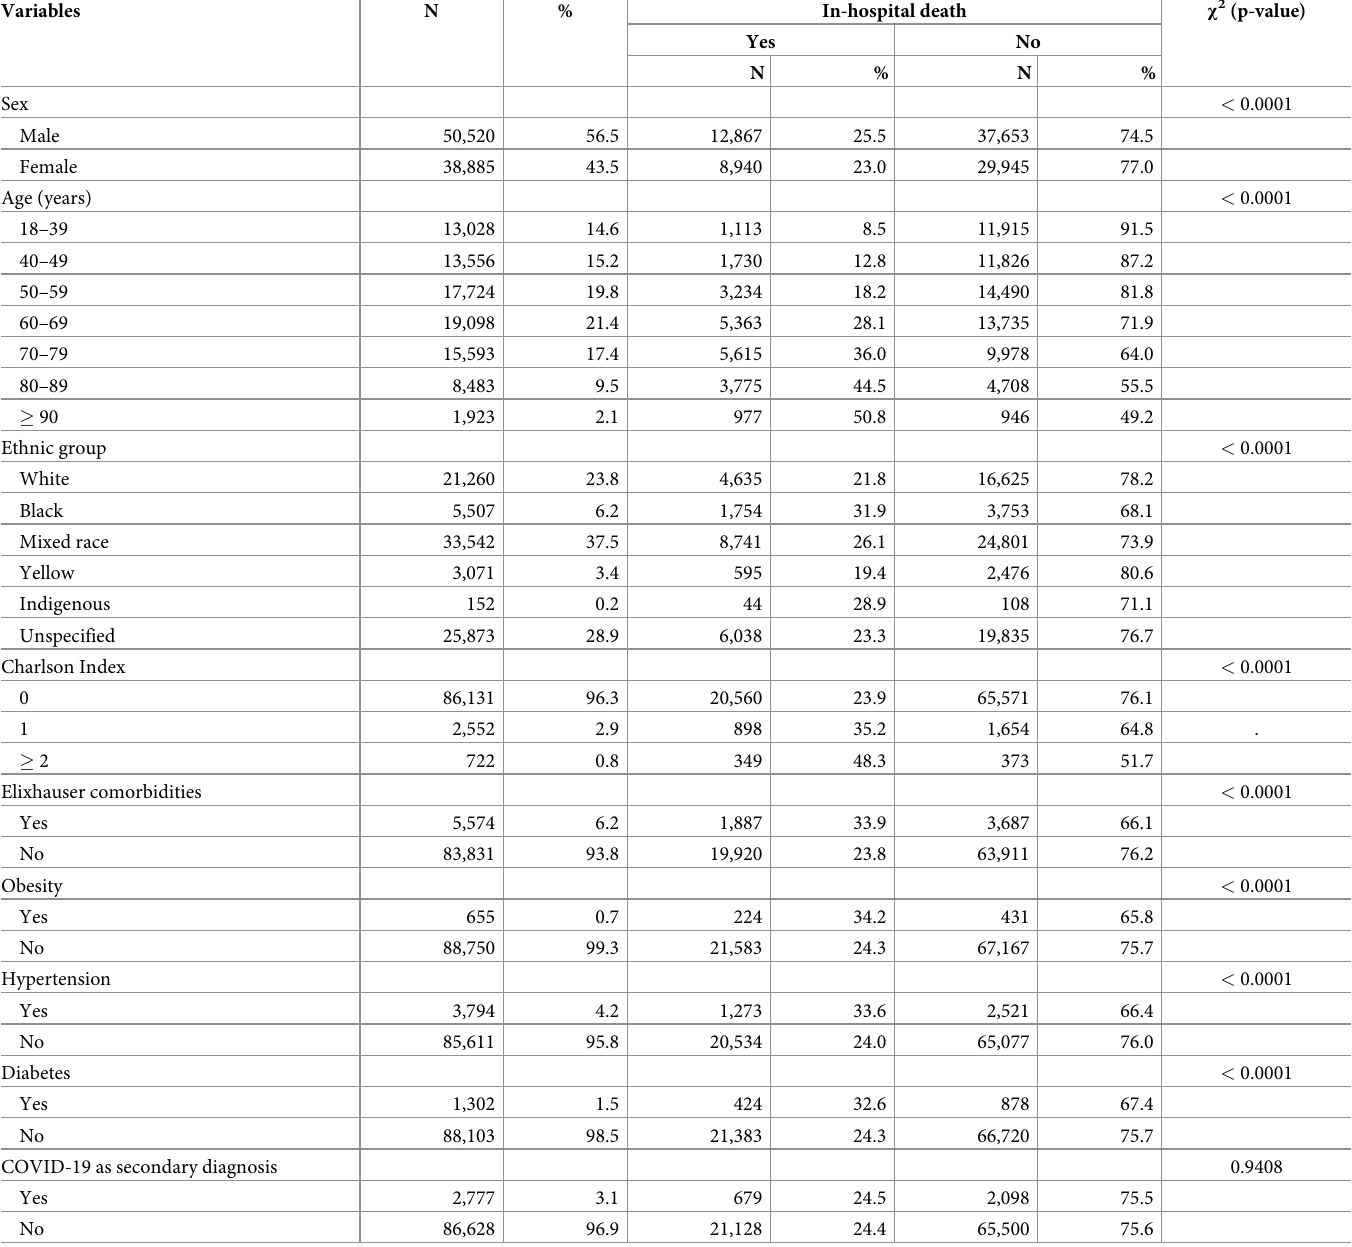
Table 1. Bivariate analyses of sociodemographic and clinical variables and in-hospital mortality. COVID-19 hospitalizations in the Unified Health System in Brazil (N = 89,405). February to June 2020. Variables